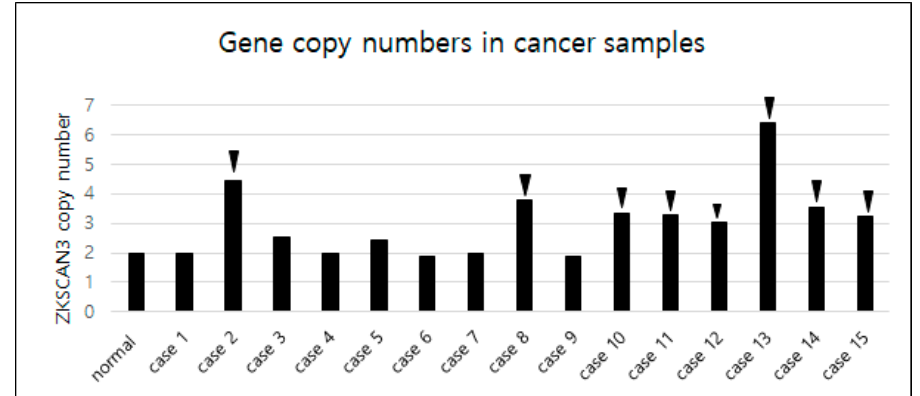
Figure 3. Gene copy number variation of ZKSCAN3 determined using qPCR and normalized to the value of normal cervical samples. Arrow heads indicate the cases with increased copies of ZKSCAN3 .